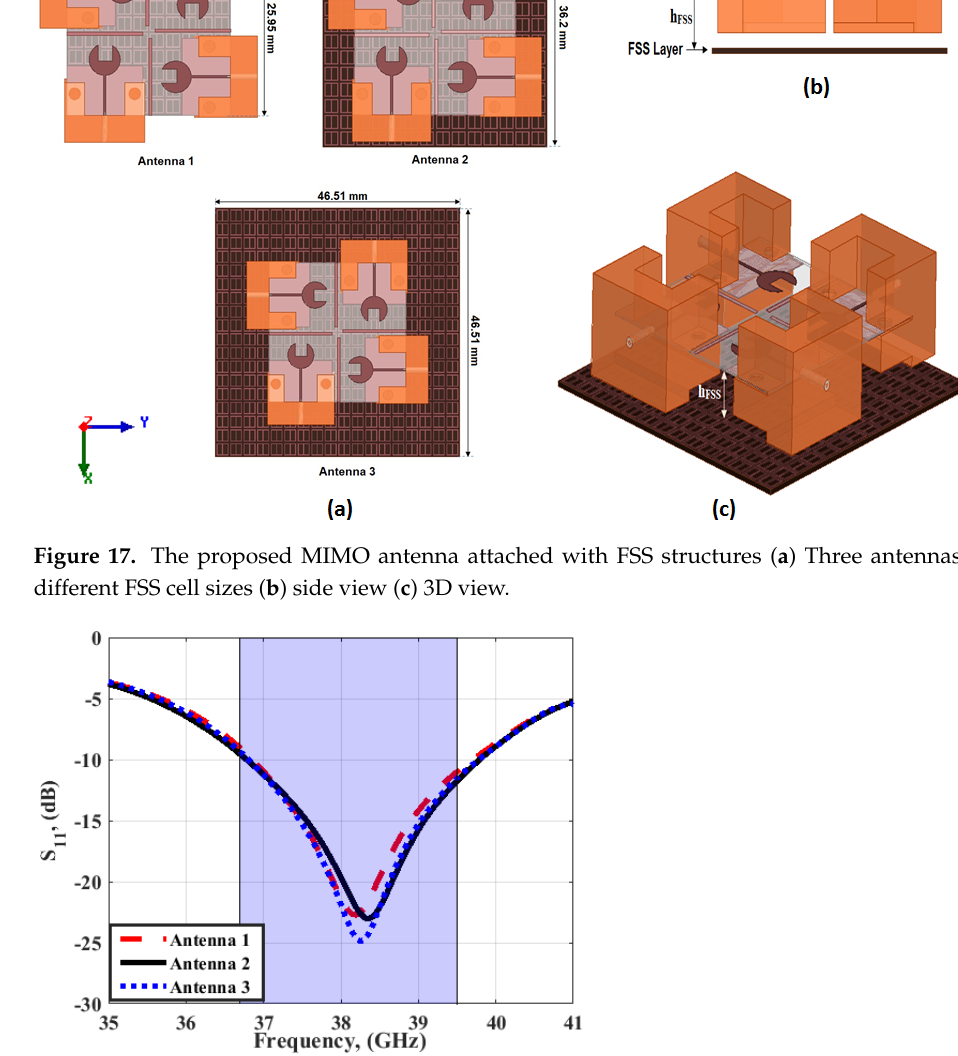
Figure 18. The simulated S 11 outcomes of the MIMO antenna at port 1 at different FSS cell sizes.